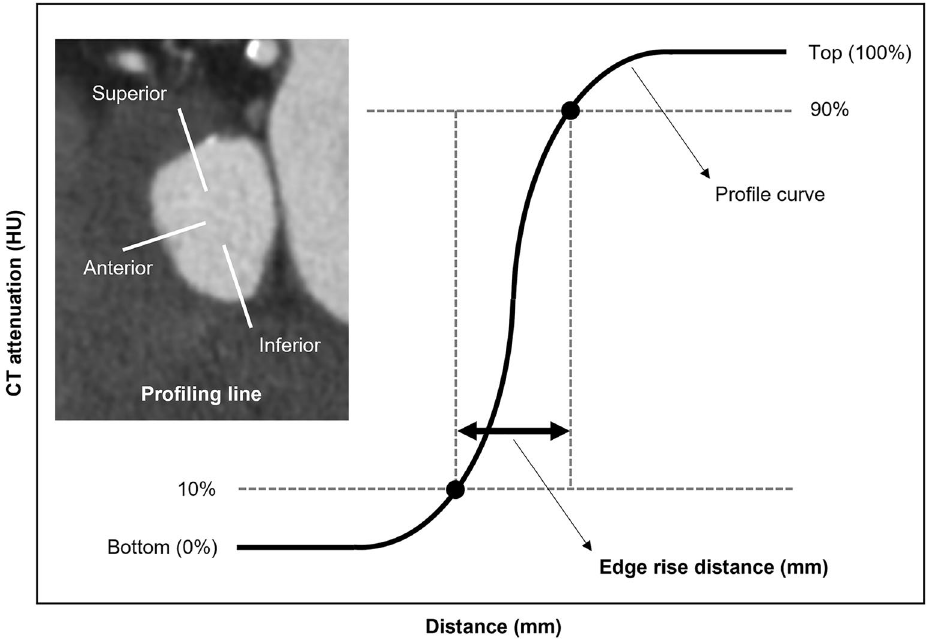
Figure 1. Sample image of ERD. Profile curve of the aortic annulus. The ERD at a pixel attenuation from 10 to 90% of the maximum CT attenuation is shown. CT = computed tomography; HU = Hounsfield units; ERD = edge rise